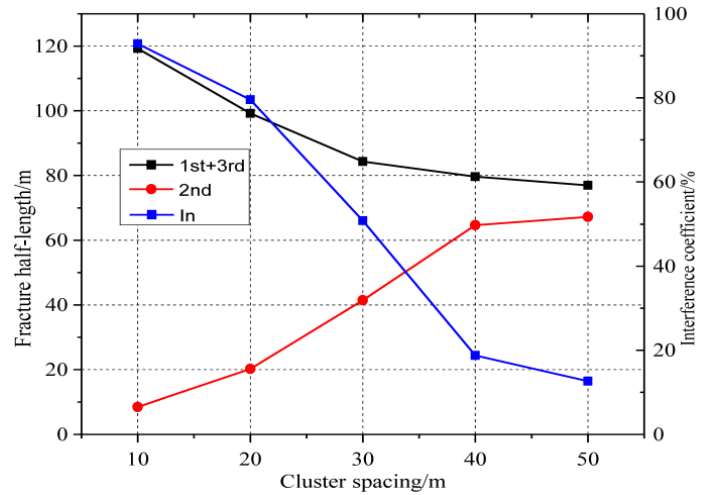
Figure 11: Fracture half-length of all fractures within the single fracturing section when the cluster spacing is different. When the cluster spacing is only 10 m, the middle fracture (the 2 nd fracture) will be strongly affected by the stress interference due to the adjacent fractures, which finally greatly hinders its full propagation. In the end, the half-length of the middle fracture is only 7% of that of the fractures on both sides within the fracturing section, and the interference coefficient even reaches 92%. With the gradual increase of cluster spacing, the stress interference among the hydraulically induced fractures has been gradually weakened, and the inhibition effect of stress interference on the propagation of middle fracture in the fracturing process has shown the same tendency. When the cluster spacing reaches 40 m, half- length of the middle fracture (the 2 nd fracture) is basically equal to that of the two fractures on both sides within the fracturing section. All these results indicate that when the cluster spacing is designed to be 40m, the stimulation result may be best. Under this condition, the length of each fracturing section is 120m, so the total number of fracturing section is 10 segments, which are in accordance with the practical fracturing